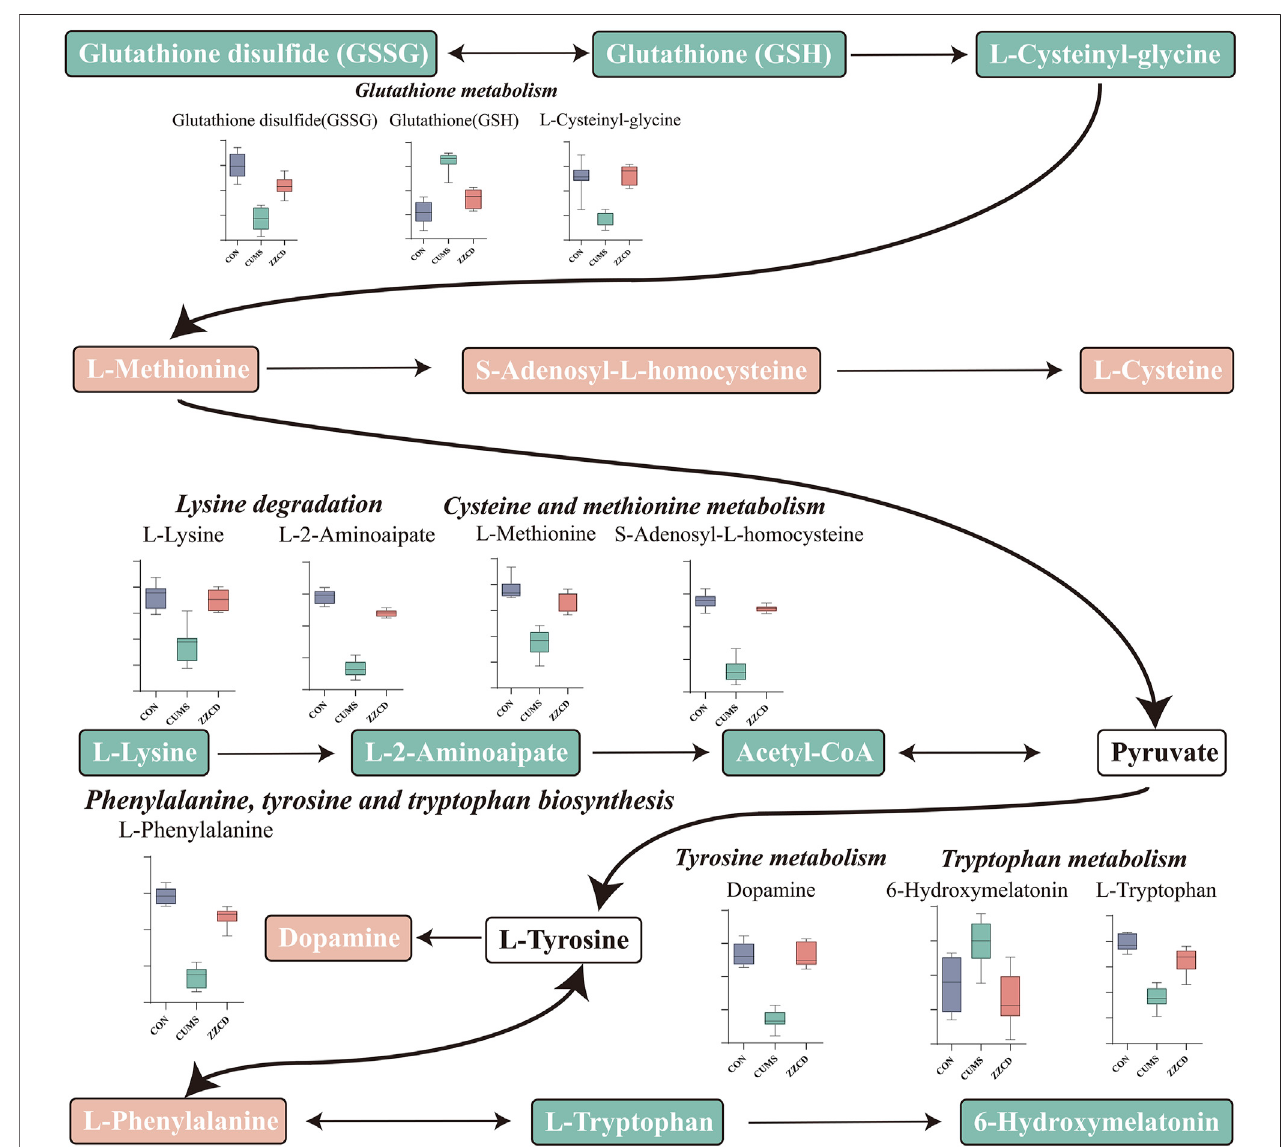
FIGURE 3 | Schematic diagram of the altered differential metabolites and disturbed metabolic pathways.